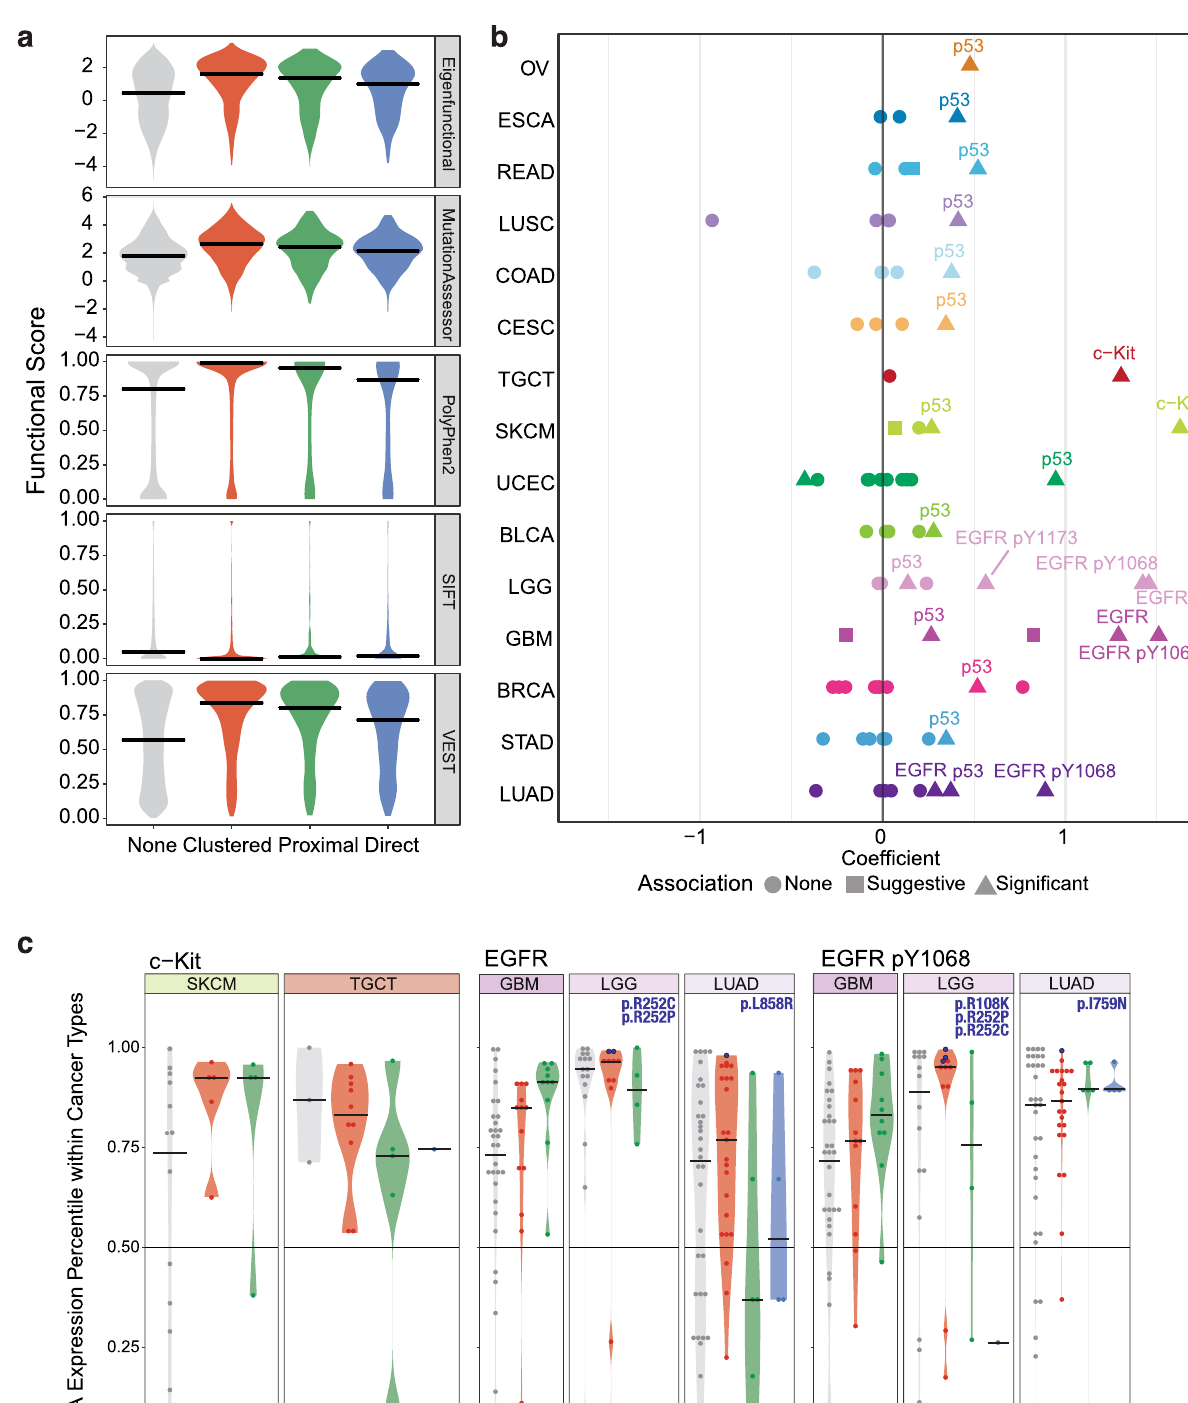
Fig. 4 Proteomic effects associated with co-clustered mutations. a Comparison of predicted functional scores, including those provided by Mutation Assessor, PolyPhen-2, SIFT, VEST, and an eigen score for mutations having different spatial interactions with phosphosites. The interaction types are direct (directly overlapping), proximal (within 2 residues in the linear distance), clustered (in hybrid clusters), and none of these interactions. b Plot showing cancer types where the carrier of each gene ’ s co-clustered mutation is associated with signi fi cantly higher or lower expression of the corresponding protein/phosphoprotein marker in the Reverse Phase Protein Arrays (RPPA) dataset. Each dot represents a gene-cancer association, where color depicts cancer type and shape shows signi fi cance. c Expression percentile of the protein/phosphoprotein marker in carriers of multiple types of mutations (direct, proximal, clustered, none) in the corresponding genes. Mutations carried by the samples with greater than 97% marker expression are further text-labeled.